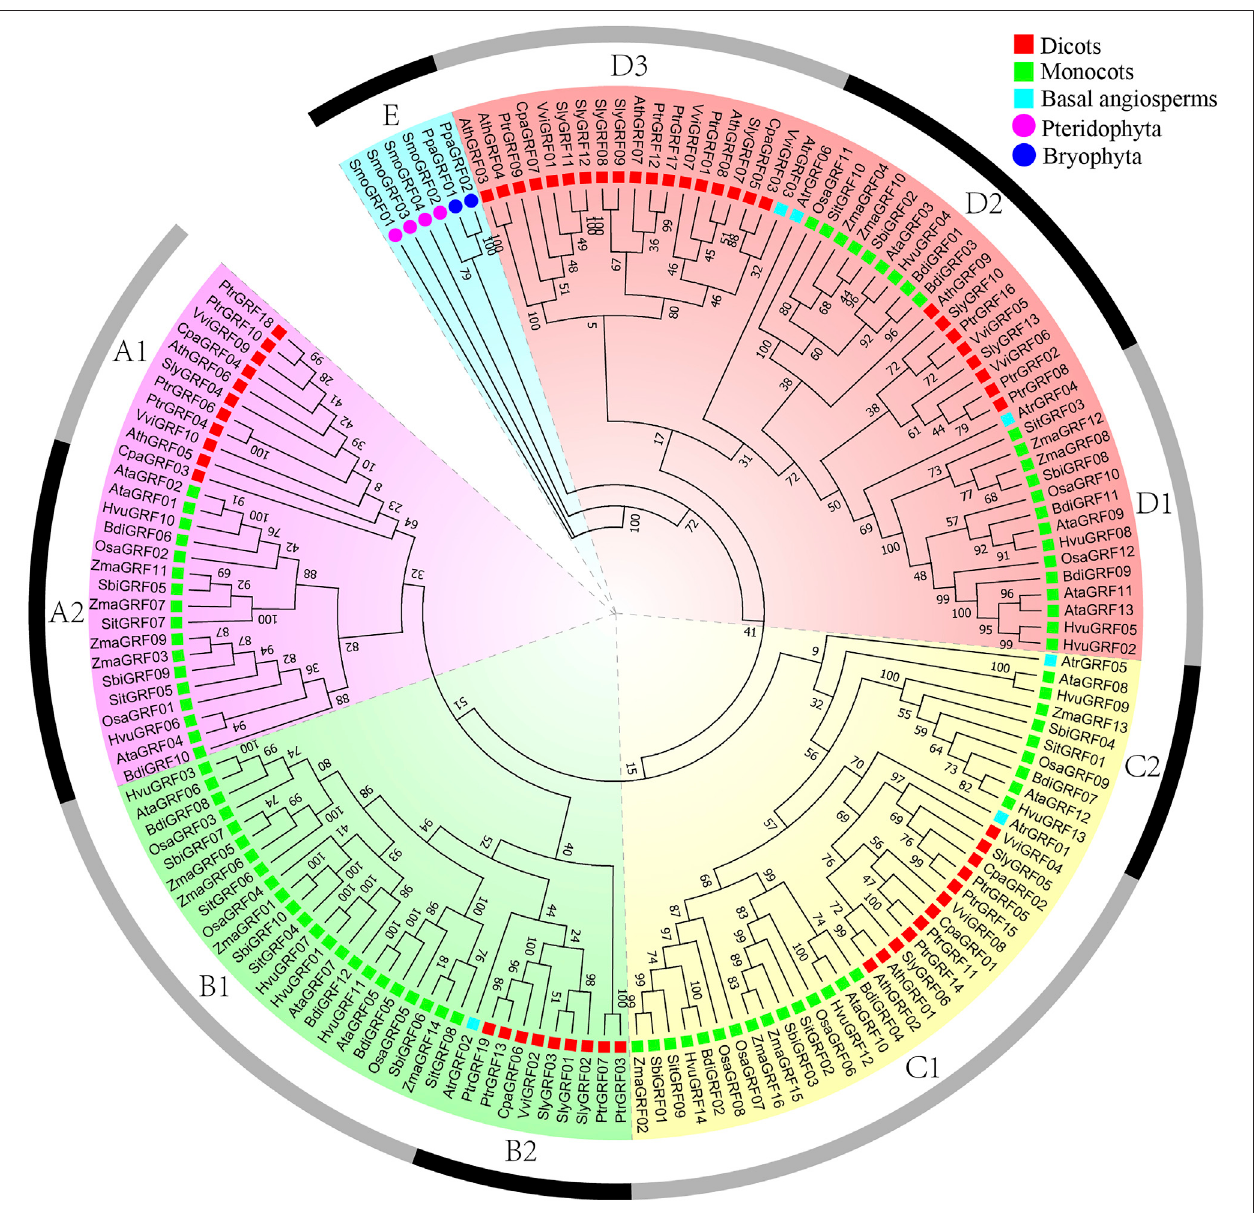
FIGURE 2 | Phylogenetic trees of GRF genes. Phylogenetic analysis of plant GRF proteins using PhyML 3.1 under JTT + I + G + F model with 1000 nonparametric bootstrap replicates.